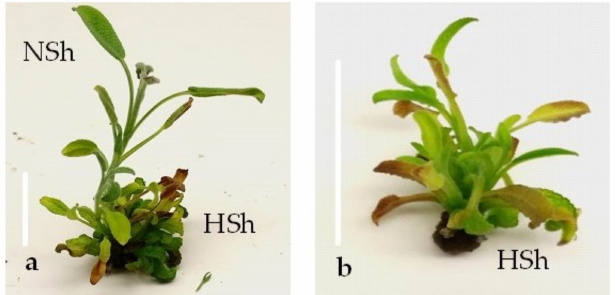
Figure 2. Responses of single node explants of S. officinalis during the multiplication stage to produce normal and hyperhydrated shoots, ( a ) or hyperhydrated shoots only ( b ). NSh = normal shoot, HSh = hyperhydrated shoot. Size bars= 1.0